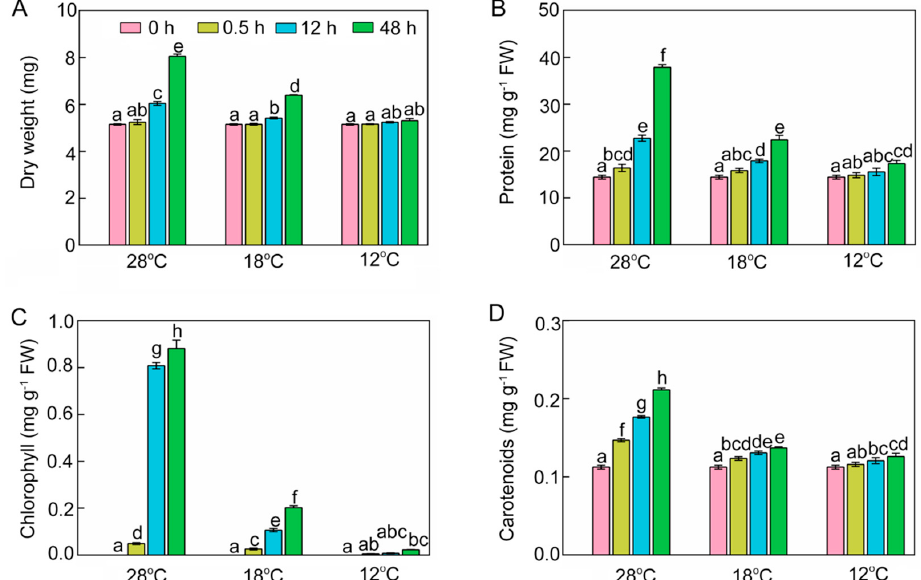
Figure 2. Dry weight (DW, A ), soluble protein ( B ), chlorophyll ( C ), and carotenoids ( D ) of control (28 °C) and chill-stressed (18 °C and 12 °C) rice seedlings after 0 h, 0.5 h, 12 h, and 48 h greening. Six day old etiolated seedlings were treated with 18°C or 12°C cold stress. Seedlings were harvested at 0 h, 0.5 h, 12 h, and 48 h of greening and their DW, protein, chlorophyll, and carotenoid contents were measured. The error bars represent standard deviations of three independent biological replicates. Different letters indicate significantly different at p < 0.05 according to Duncan’s multiple range